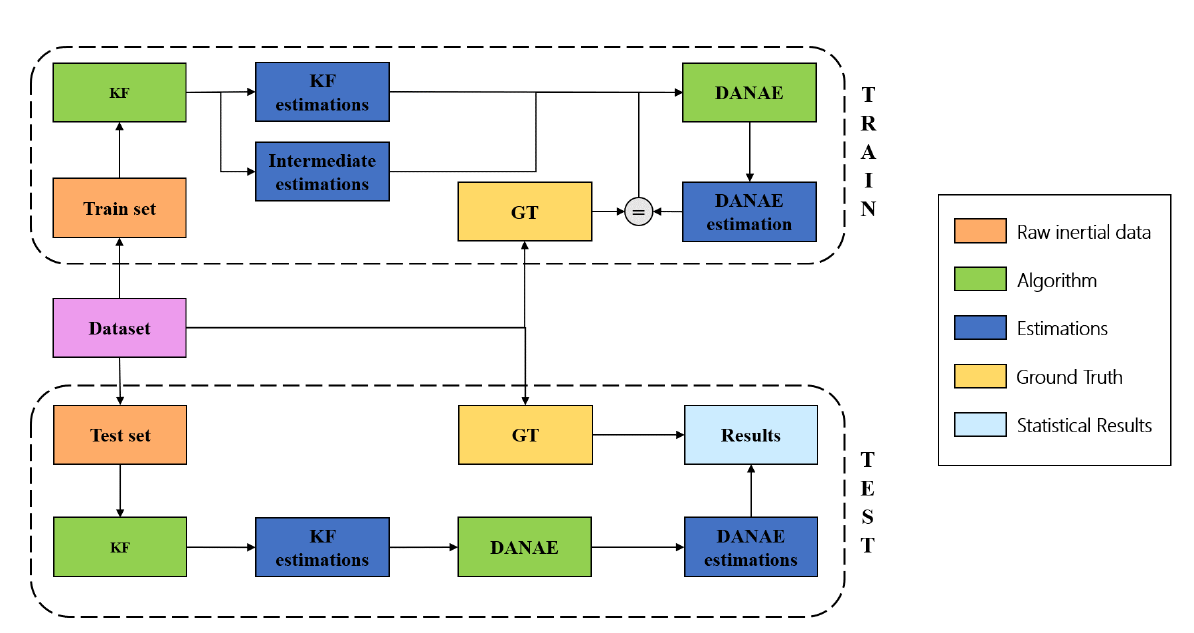
Figure 2. Workflow of the experiments: the upper section summarizes the training phase, while the bottom section represents the relative testing